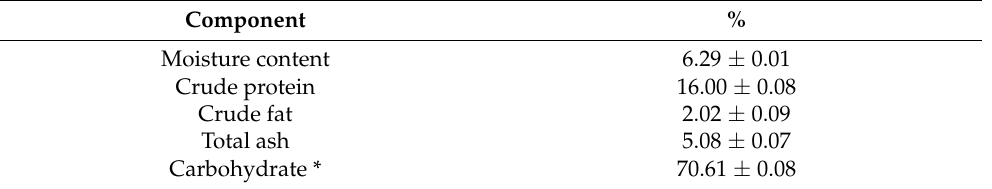
Table 1. Proximate composition of the P. koidzumii sorbent.